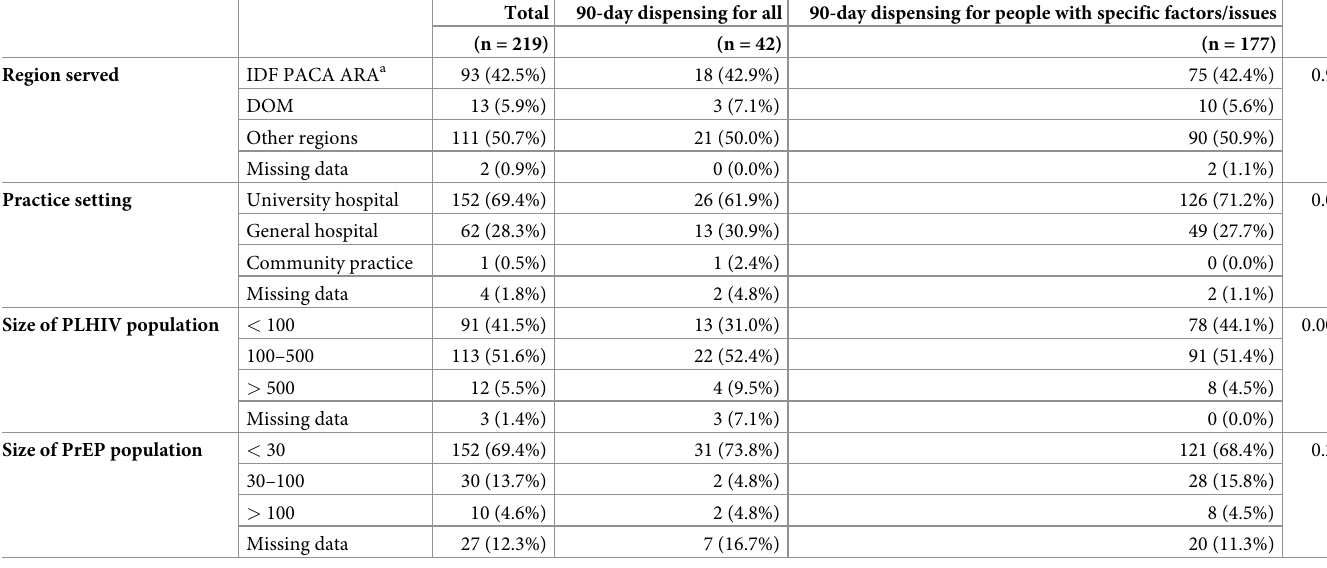
Table 4. Characteristics of the 219 doctors endorsing 90-day dispensing of ART for all vs only for people with eligible therapeutic criteria and with good immune and virological factors and/or favourable social issues.